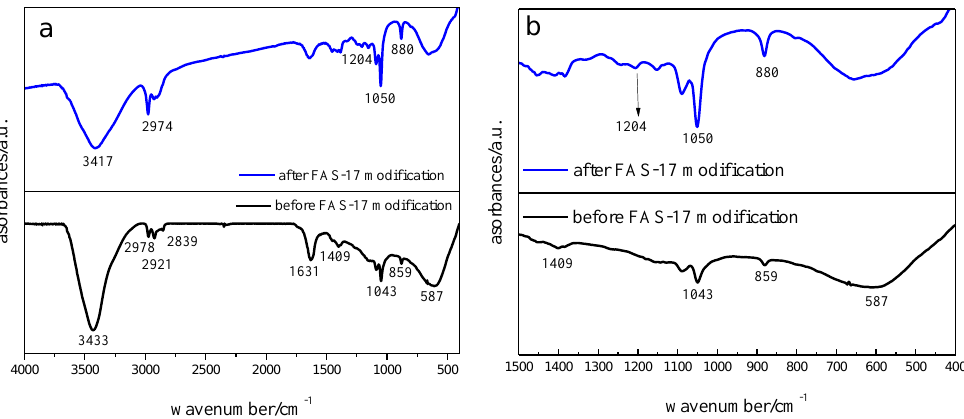
Figure 3. FT – IR spectra of conversion-coated 5052 aluminum alloy before FAS-17 modification and after FAS-17 modification: ( b ) is ( a ) with partial enlargement.